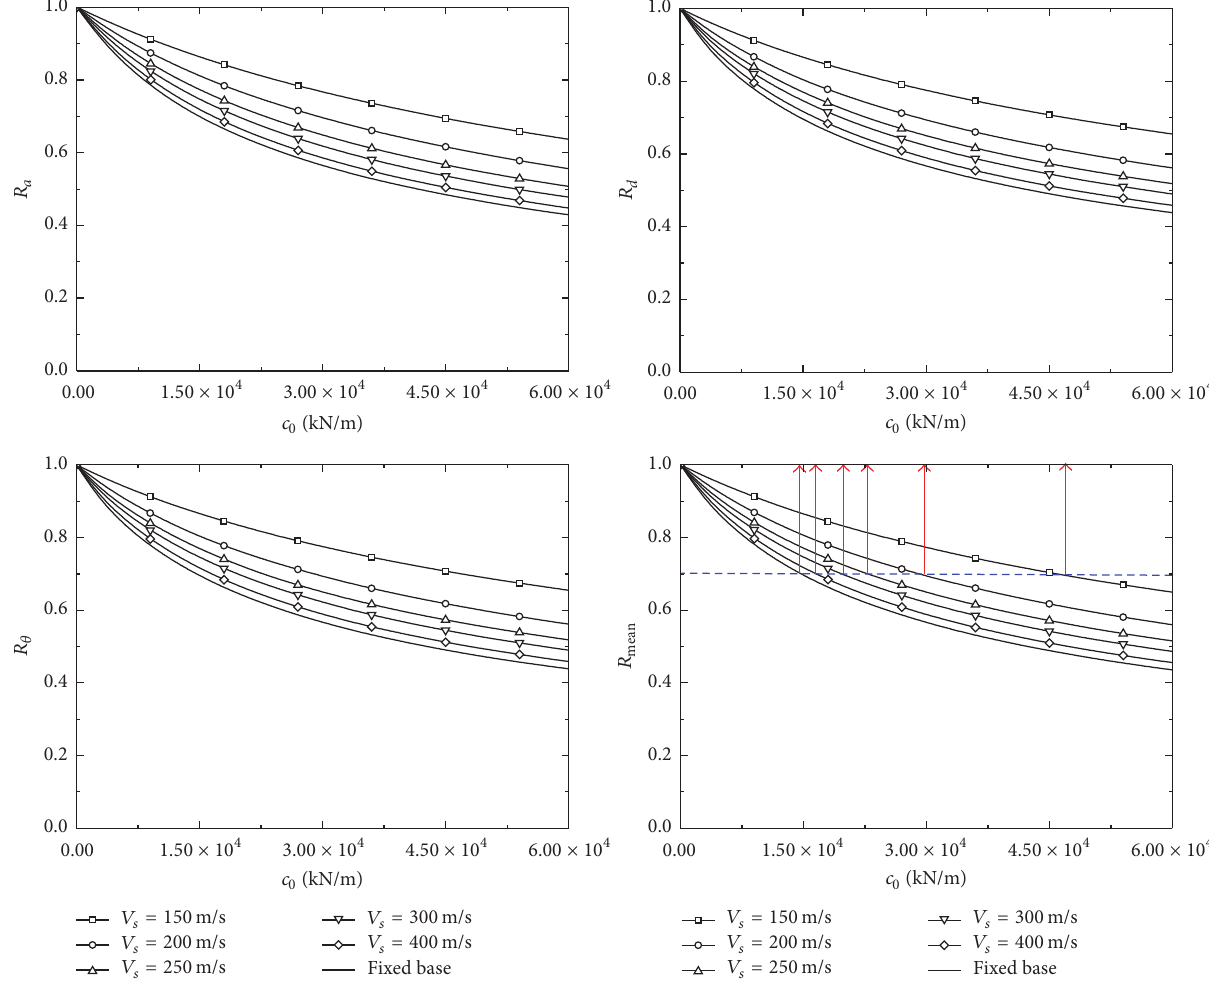
Figure 8: The reduction ratios for 20-story structures ( 𝐸/𝑅 = 1 ).